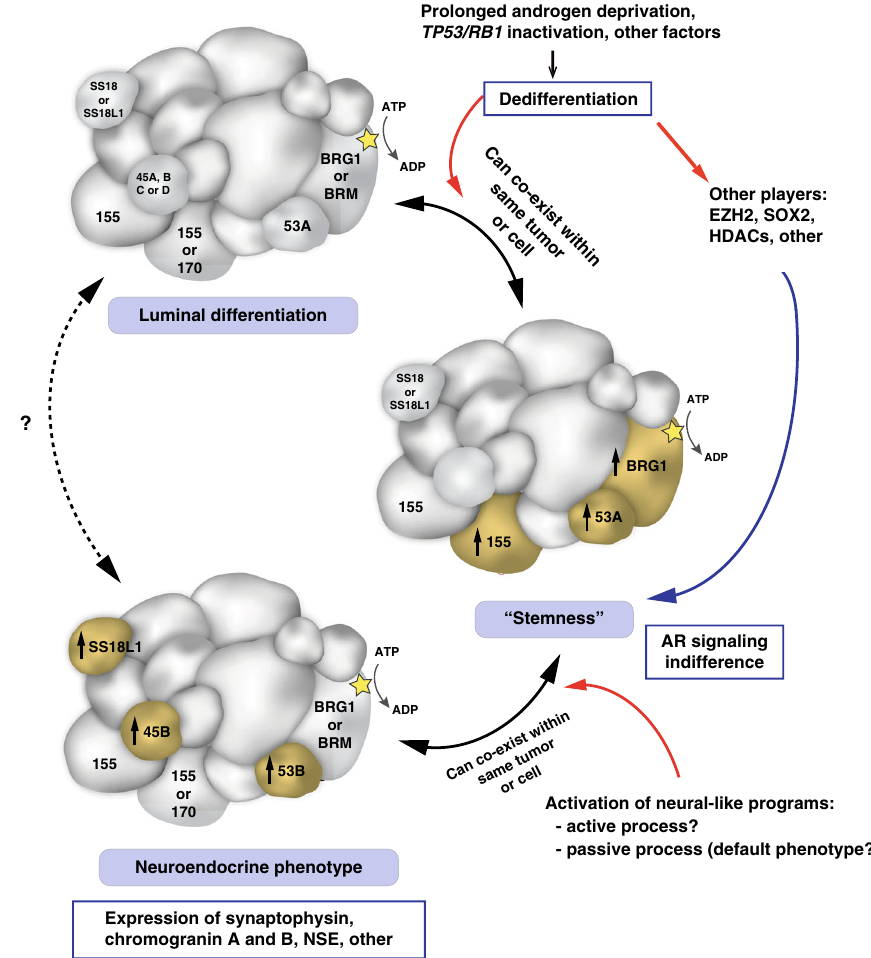
Fig. 5 Schematic representation of putative specialized SWI/SNF assemblies in prostate cancer cells. Hypothetical SWI/SNF assemblies are shown in the context of current knowledge about prostate cancer phenotype plasticity. Subunits of particular interest are annotated with their names. Two names within a subunit indicate possible incorporation of either one of the two paralogs. Subunit sizes are approximately indicative of their molecular weights. 155: BAF155, 170: BAF170, 53A: BAF53A, 53B: BAF53B, 45B: BAF45B, AR: Androgen unique hormone treatment-naïve prostatic adenocarcinoma (Adeno), 245 castra- tion resistant prostate adenocarcinoma (CRPC-Adeno), and 56 castration resistant neuroendocrine prostate carcinoma (CRPC-NE) patients. Two-tailed proportion test has been used to check enrichment of hemizygous deletion and copy number neutral loss. RNA-seq data analysis of human samples . RNA-seq data from 32 normal prostate samples 89,90 , 400 localized PCa 37,89,90 and 120 CRPC-Adenos and 20 CRPC-NE patients 4,5 were utilized for the initial investigation of the SWI-SNF complex units levels and were processed as follows. Reads (FASTQ fi les) were mapped to the human genome reference sequence (hg19/GRC37) using STAR v2.3.0e 91 , and the resulting alignment fi les were converted into Mapped Read Format (MRF) for gene expression quanti fi cation using RSEQtools 92 and GEN- CODE v19 (http://www.gencodegenes.org/releases/19.html) as reference gene annotation set. A composite model of genes based on the union of all exonic regions from all gene transcripts was used, resulting in a set of 20,345 protein- coding genes. Normalized expression levels were estimated as FPKM. After con- verting the FPKM via log2 (FPKM + 1), differential expression analysis was per- formed using Mann-Whitney Wilcoxon test. RNA-seq data of the SU2C-PCF cohort were downloaded from original study 5 . NEPC score and AR signaling score were inferred as previously described 5 . Gleason scores of the TCGA PCas were retrieved from the original study 37 . RNA-seq data and Gleason score from the TCGA PCa dataset were retrieved from the TCGA data portal using TCGAbiolinks R package v2.12.2 93 . Immunohistochemistry . Immunohistochemistry (IHC) was performed on sec- tions of formalin- fi xed paraf fi n-embedded patient tissue (FFPE) using a Bond III